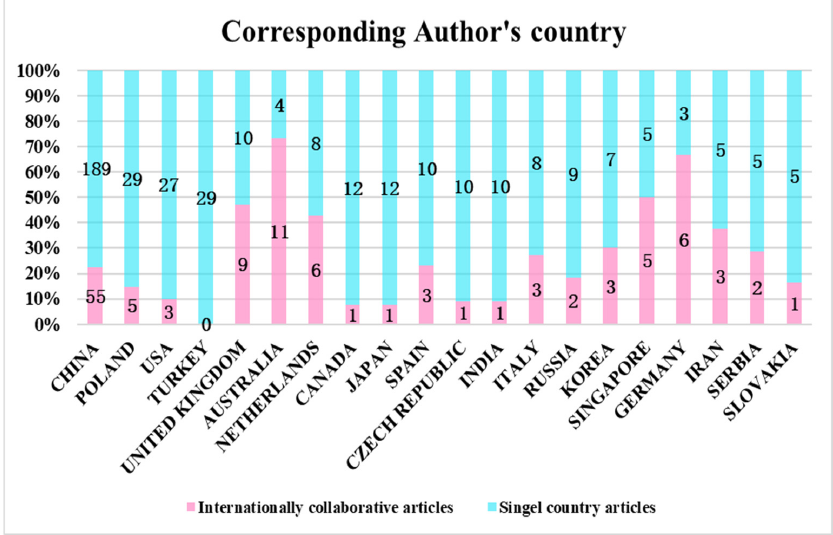
Figure 9. Corresponding authors’ nationalities in the 20 most prolific countries in the field of land consolidation.